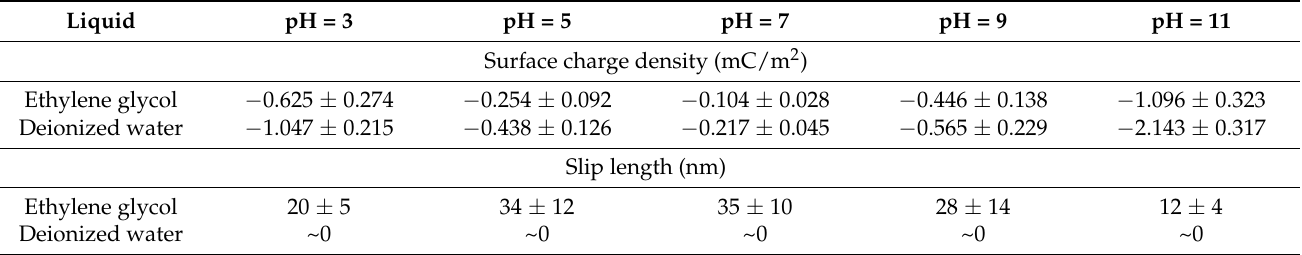
Table 3. Surface charge density and slip length of sphere immersed in ethylene glycol and deionized water at the pH range of 3 to